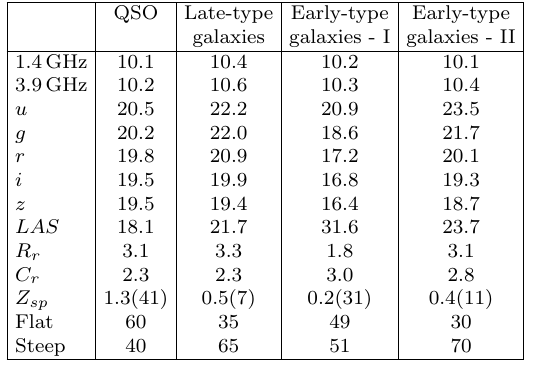
Table 2. Parameters of four sub-samples of the optically identified RCR sources